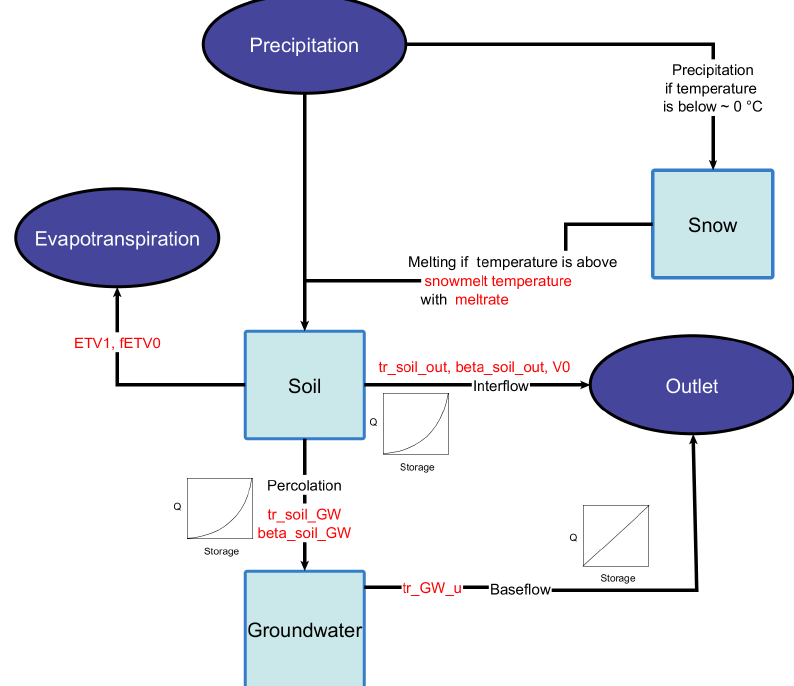
Figure 9. Structure of the final Model 15 with water storages (light blue), boundaries (dark blue), temporary storages (white), calibrated parameters (red), fluxes (black arrows) and flow curves (for all applicable fluxes). Water reaching the outlet is shifted 1 day into the